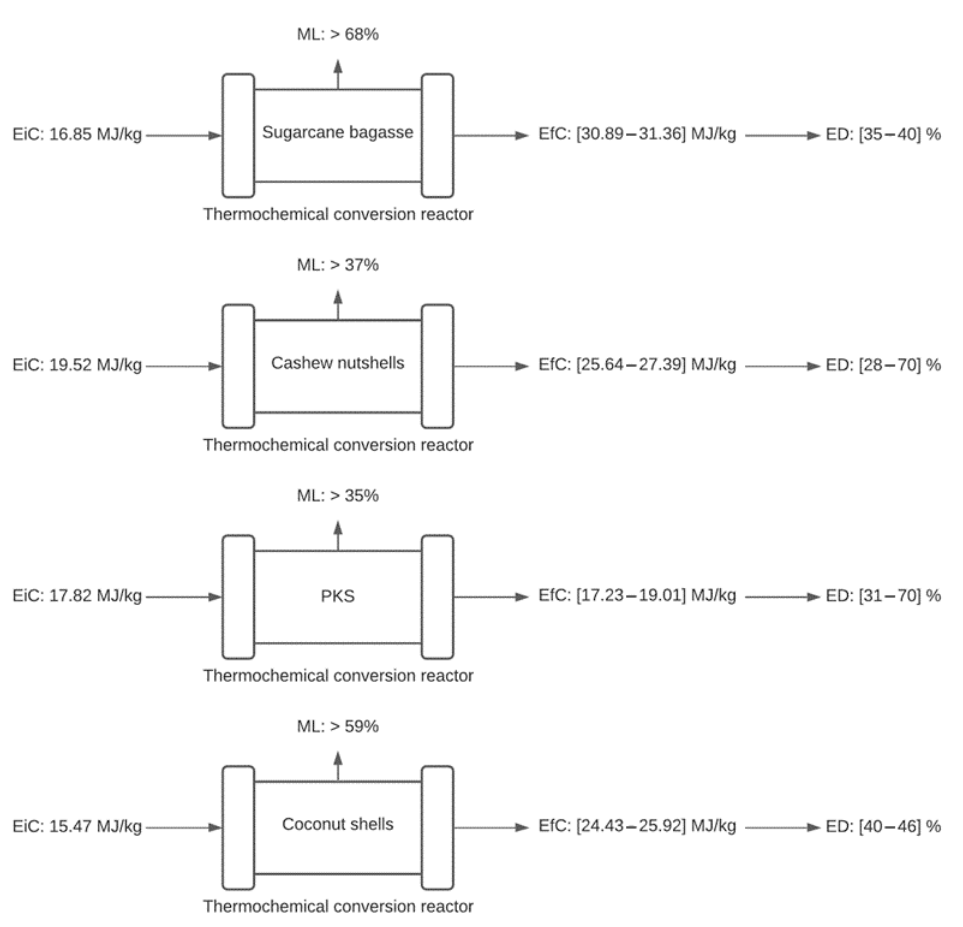
Figure 3. Mass and energy balance (EiC–Initial Energy Content, ML–Mass Loss, EfC–Final Energy Content, ED–Energy